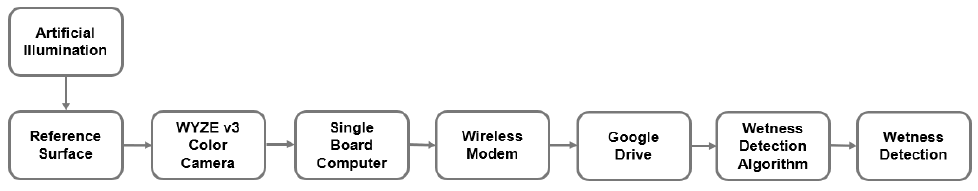
Figure 3. Block diagram of the system to monitor a reference surface and to detect wetness from images of the reference surface.